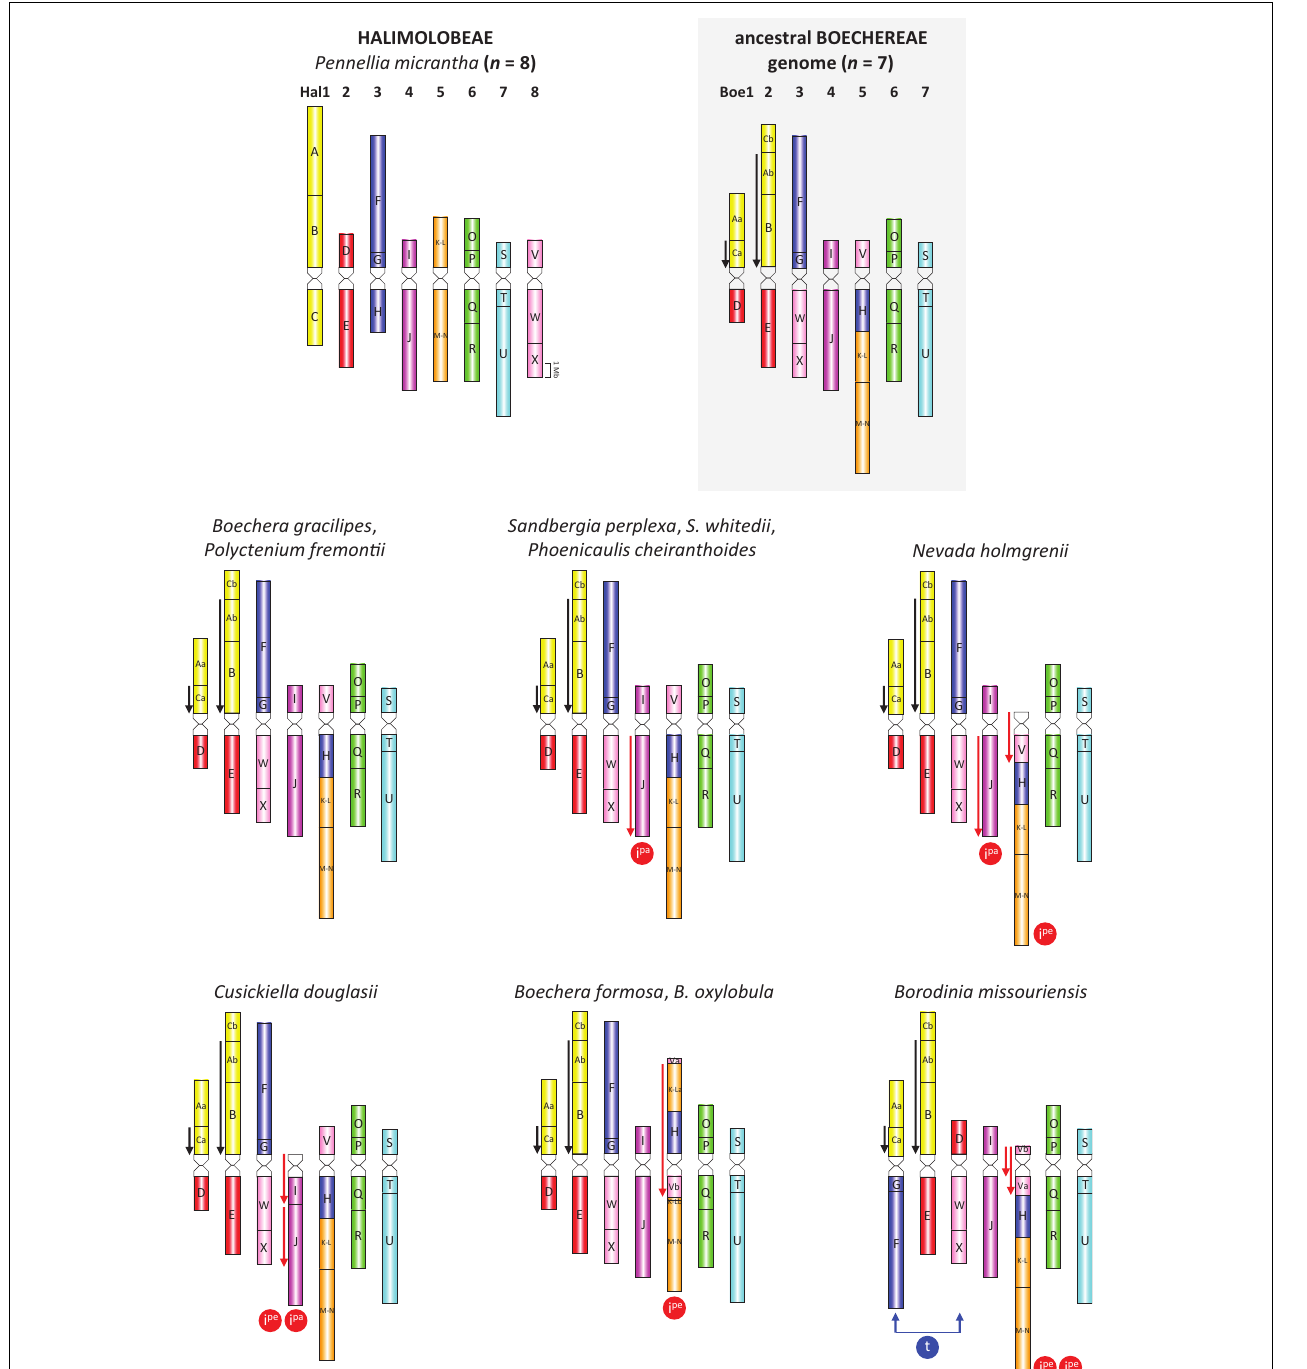
FIGURE 2 | Comparative cytogenomic maps of Pennellia micrantha (Halimolobeae), the ancestral Boechereae genome, and 10 analyzed Boechereae species. As subgenomes of the polyploid species/cytotypes have the same structure, only a single (sub)genome is shown for triploids ( P. cheiranthoides , S. whitedii ) and tetraploids ( C. douglasii , P. cheiranthoides , P. fremontii ). Color coding of 22 genomic blocks (A to X) reflects their position on the eight ancestral chromosomes (AK1–AK8) in the Ancestral Crucifer Karyotype (Lysak et al., 2016). Blocks split into two segments are labeled as “a” and “b.” Downward-pointing arrows denote the inverse orientation of GBs compared to their position in the ACK represented here by the P. micrantha genome. Black arrows mark the Boechereae-specific inversions which occurred prior to the divergence of the tribe, whereas red arrows denote genus- and species-specific inversions that occurred after the divergence of Boechereae. I pe : pericentric inversion; I pa : paracentric inversion; t: whole-arm translocation. All ideograms are drawn to scale, whereby the size of GBs corresponds to the size of homeologous blocks in the Arabidopsis thaliana genome (The Arabidopsis Information Resource, TAIR; http://www.arabidopsis.org). Genome structure of P. cheiranthoides was adopted from Mandáková et al. (2020).